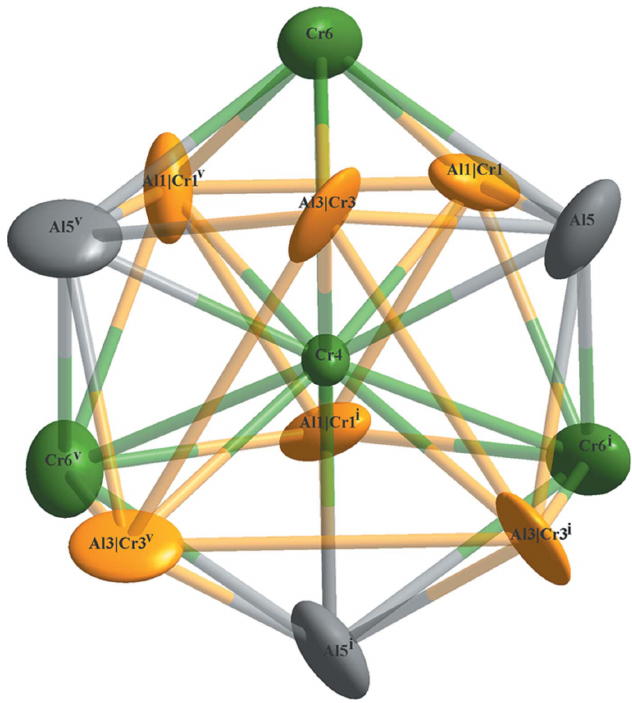
Figure 2 The environment of the Cr4 atom. Displacement ellipsoids are given at the 99% probability level. [Symmetry codes: (i) y , z , x ; (v) y , z , x .]